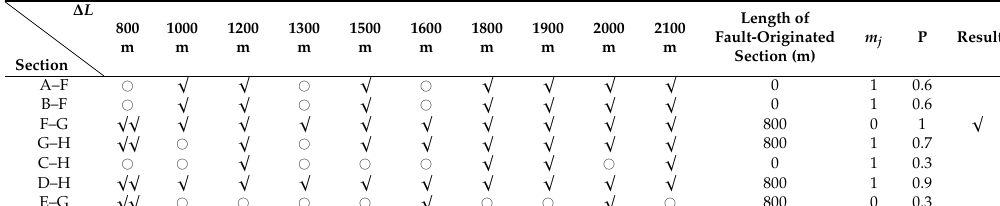
Table 4. Calculation of the probabilities based on the data measured at E.